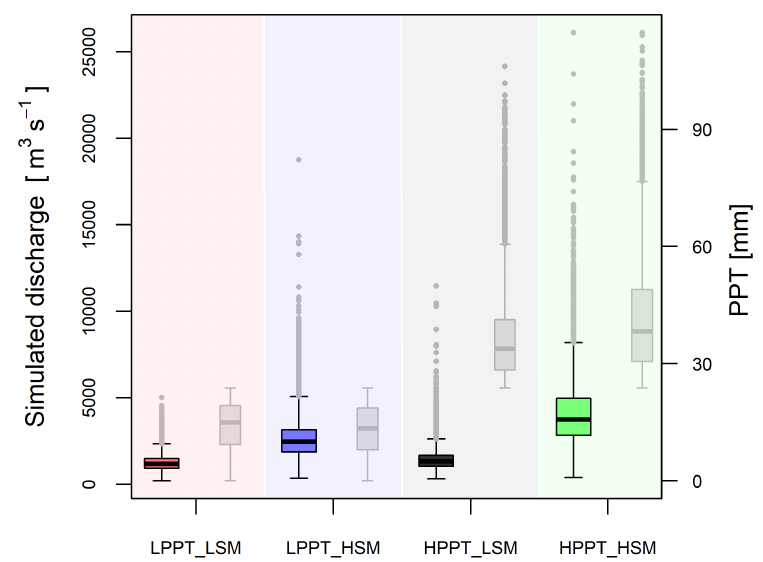
Figure 7. Simulated discharges for four different sampling scenarios: LPPT_LSM indicates below median 10-day precipitation in combination with climatological low initial soil moisture (<10% quantile), HPPT_HSM high precipitation/high soil moisture (>90% quantile), and HPPT_LSM and LPPT_HSM show corresponding combinations. The colored boxes show the distribution of discharge in each bin, the grey boxes the distribution of 10-day precipitation sums (right axis